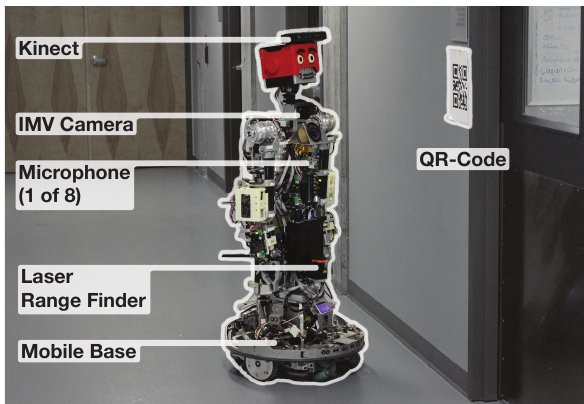
Figure 8: Tour-guiding with IRL-1/TR.